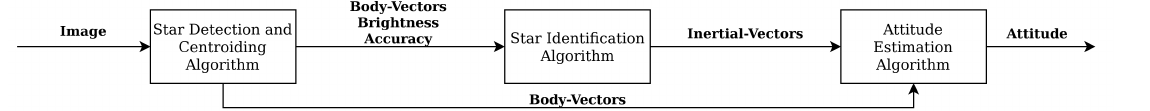
Figure 2. Functional flow star